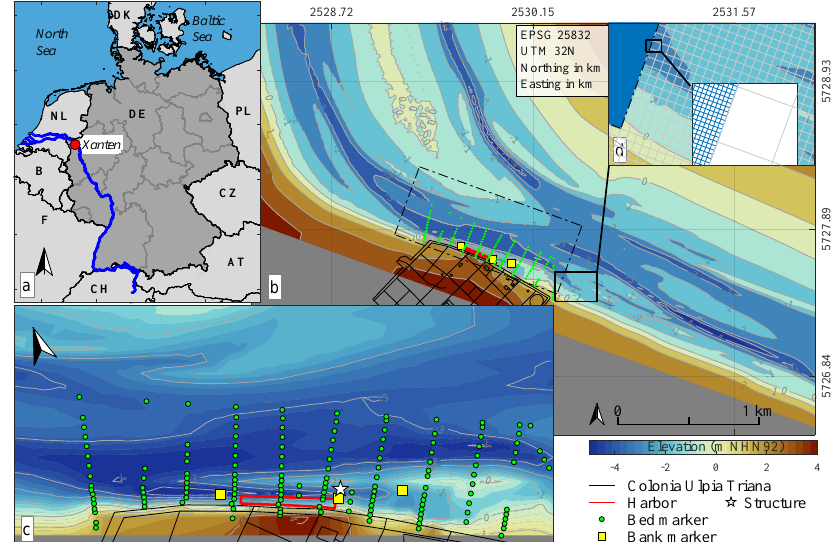
Figure 5. Overview Map with ( a ) the location of Xanten in relation to the Rhine in Europe ( b ) the modelled historic Rhine river bed and ( c ) detailed view of the roman riverine harbour location at the CUT with the position of the possible current deflection wall (CDW). Subfigure ( d ) examplifies the different grid resolutions of the two model